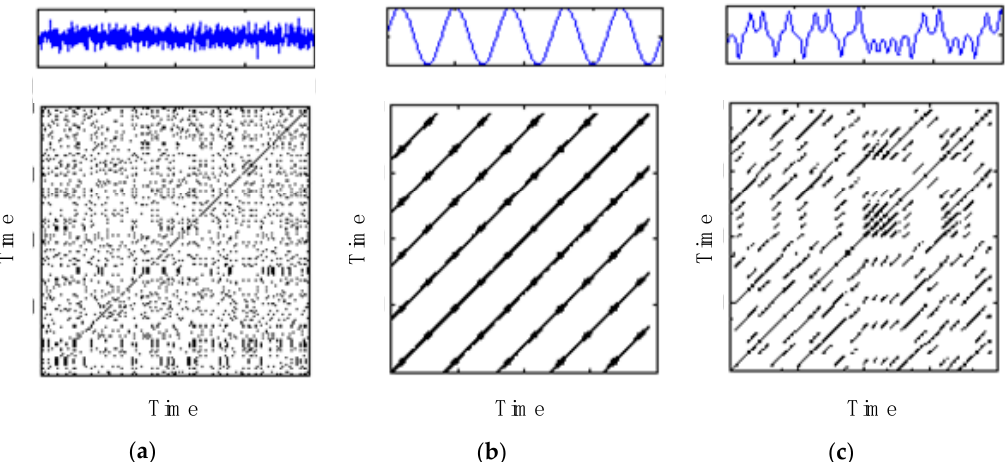
Figure 2. Different types of signals and their RPs. ( a ) white noise; ( b ) a periodic signal (cosine wave); and, ( c ) a chaotic system (the Lorenz system). There are also microscopic features, such as single dots, diagonal lines, and vertical and horizontal lines in the RP. The appearance of single dots indicates that the corresponding state does not last or greatly fluctuates. Diagonal lines consist of a series of adjacent recurrence dots, and most of them are parallel to the main diagonal line. A diagonal line represent that the system track is similar in the same direction within a certain time period, and its length represents the degree of determination or predictability. Vertical or horizontal lines represent time segments that remain unchanged or change very slowly, and they are typical behaviors of the state of the laminate, which can reveal the discontinuity of the signal.